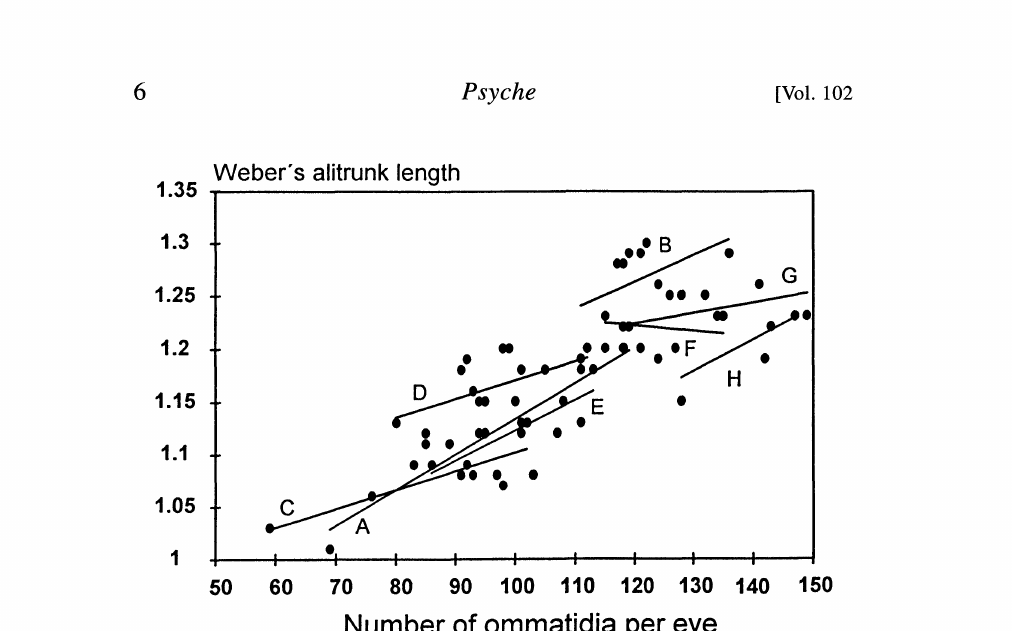
Fig. 3: Relation between WL and ommatidia number in queens of Ponera coarc- tata. The letters with corresponding regression lines represent the size spectrum within single colonies. End points of regression lines represent the ommatidia num- ber of the smallest and the largest queen of that colony, respectively. Colony A: n 16, B: n=8, C: n 4, D: n= 13, E: n 6, F: n= 7, G: n= 7, H: n=